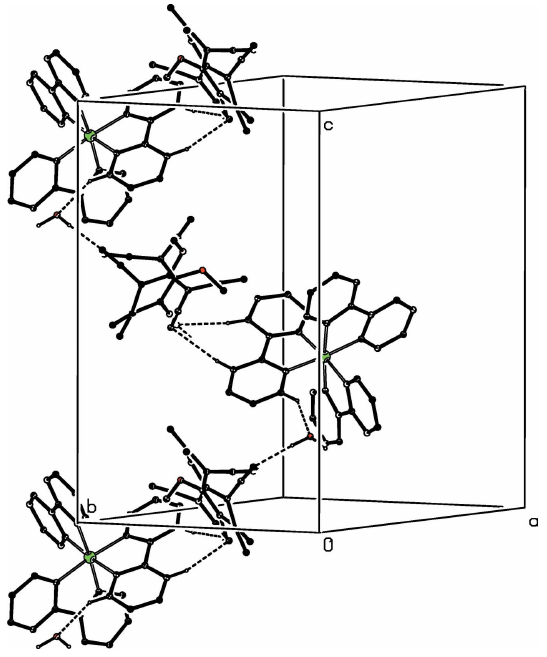
Figure 8 Part of the crystal structure of compound (I) showing the formation of a hydrogen-bonded chain running parallel to the [001] direction. For the sake of clarity, the type 1 anion and the H atoms not involved in the motif shown have been